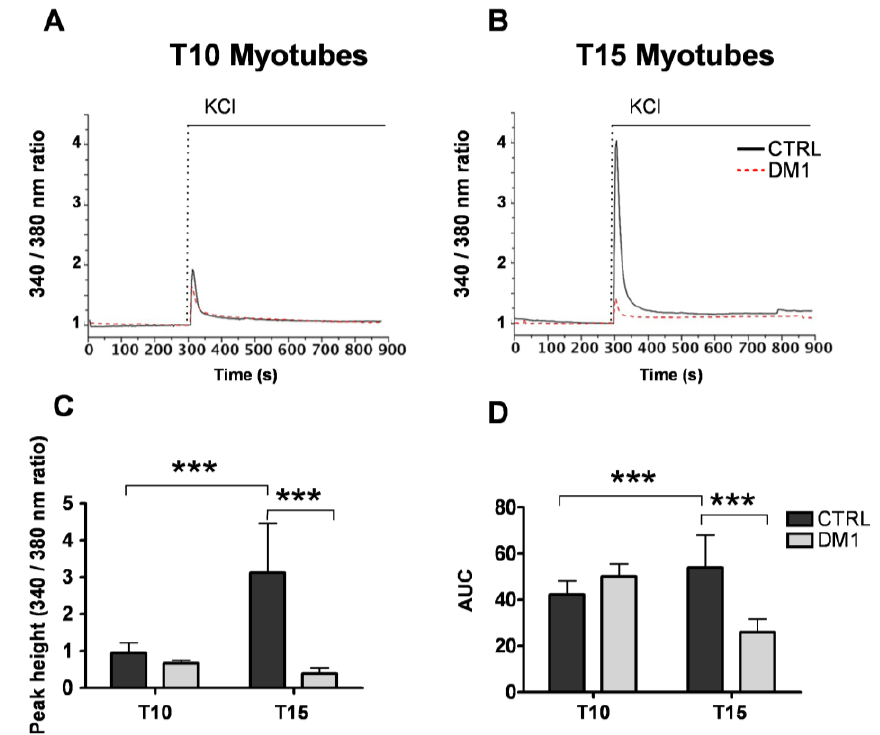
Figure 1. Depolarization induced cytosolic Ca 2+ responses in control and Myotonic Dystrophy type 1 (DM1) myotubes at sequential stages of differentiation.